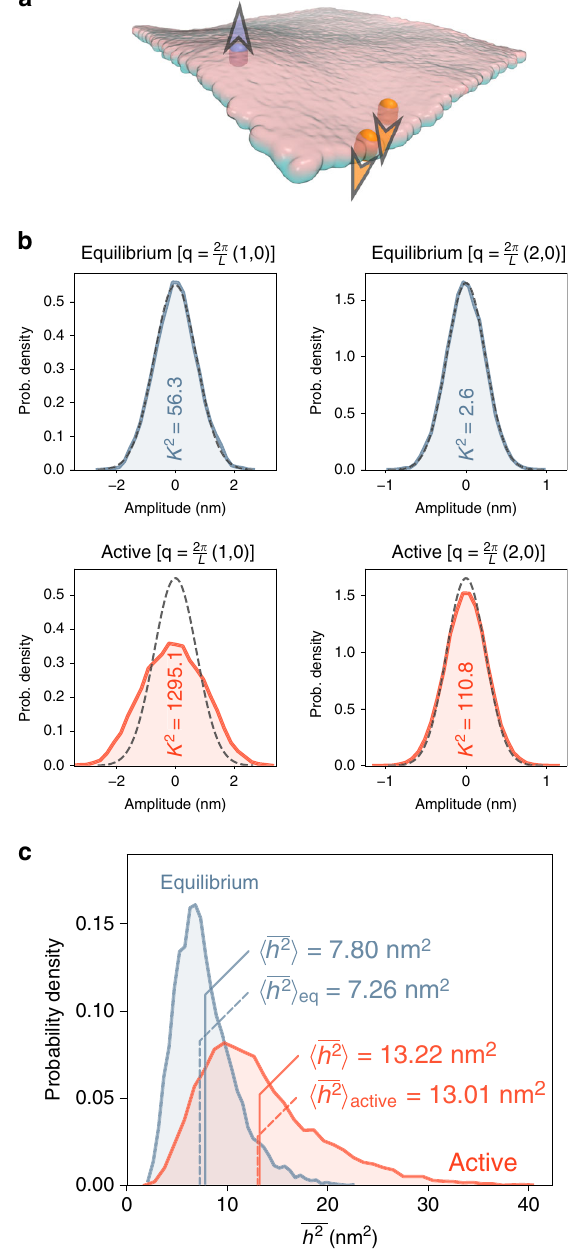
Fig. 5 Non-equilibrium steady-state kinetics of membranes containing active pump proteins. a Snapshot of the membrane and three active sites in the UP and DOWN states. b Distributions of the amplitude of two undulatory modes of the membrane with the given wave vectors q , in thermal equilibrium (blue) as well as non-equilibrium steady state with active proteins (red). Both real and imaginary parts of h q are binned together. Dashed lines are Gaussians fi tted to the equilibrium distribution, repeated in the second-row plots for comparison. The K 2 values from D'Agostino – Pearson test for the normality of the distribution 55 , which are based on sample kurtosis and skewness, are given for each case. c Distribution of the squared height of the membrane, averaged across the projected area, for the equilibrium and active cases. Values of the mean- squared out-of-plane displacement of the membrane, h h 2 i , for both equilibrium and active cases, are compared with the corresponding theoretical predictions h h 2 i and h h 2 i (Eqs. (19) and eq active